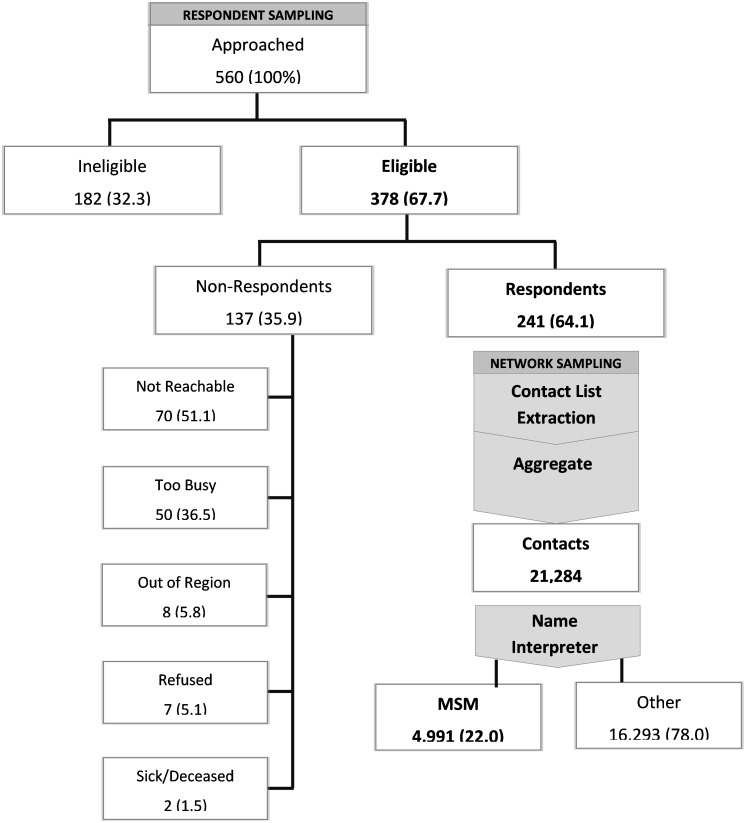
Sample recruitment schema of study respondents (n = 241), Southern India 2010.Non-respondents were eligible participants who did not present for informed consent at a nearby field office following field recruitment. Name interpreters are a series of questions asked about contact list members of respondents. In this case respondents identified contact list members as MSM or not MSM.